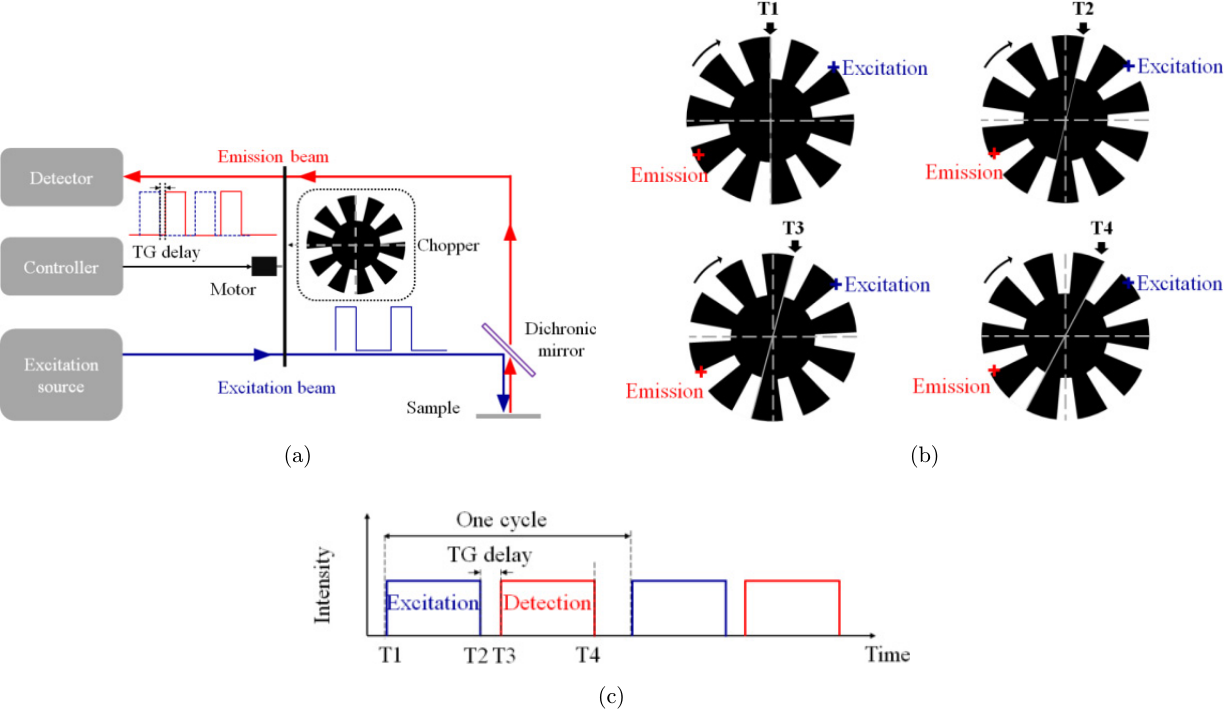
Fig. 6. (a) TG implementation of OC-(iv). (b) Illustration of the spatial alignment of the excitation and emission beam spots with the chopper. When the chopper is rotating, four on/o® switches of excitation/emission occur and are denoted as T1, T2, T3, and T4. (c) Excitation duration and TG detection window in a TG acquisition cycle. Note that the beam spots are assumed to be in¯nitely small. A phase di®erence between the excitation and detection is achieved by virtue of the spatial alignment mentioned in (b), and thus, TG detection is